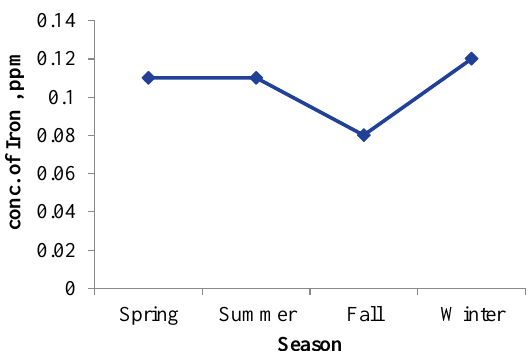
Figure 9. The average concentration of Iron by season 2008-2013 High levels of manganese were obtained from well No. 8 (Figure 10). Besides, as the figure 11 shows, the concentration of manganese in 2008 was significantly higher than the other years. Seasonal manganese level in water samples is displayed in figure 12, showing the highest amount of manganese in spring. The use of fertilizers containing manganese sulfate, that is usual in the rice farming, and the drainage of most of the leachate to the groundwater can be a reason for this increase. These results showed that the amount of manganese was suitable and lower than standard for drinking. Also in another study carried out in Birjand and Ilam, the amount of manganese was reported 0.02 and 0.01 mg/l, respectively 22 that was lower than WHO 13 and Iran 23 drinking water standards which is 0.05 mg/l for manganese.